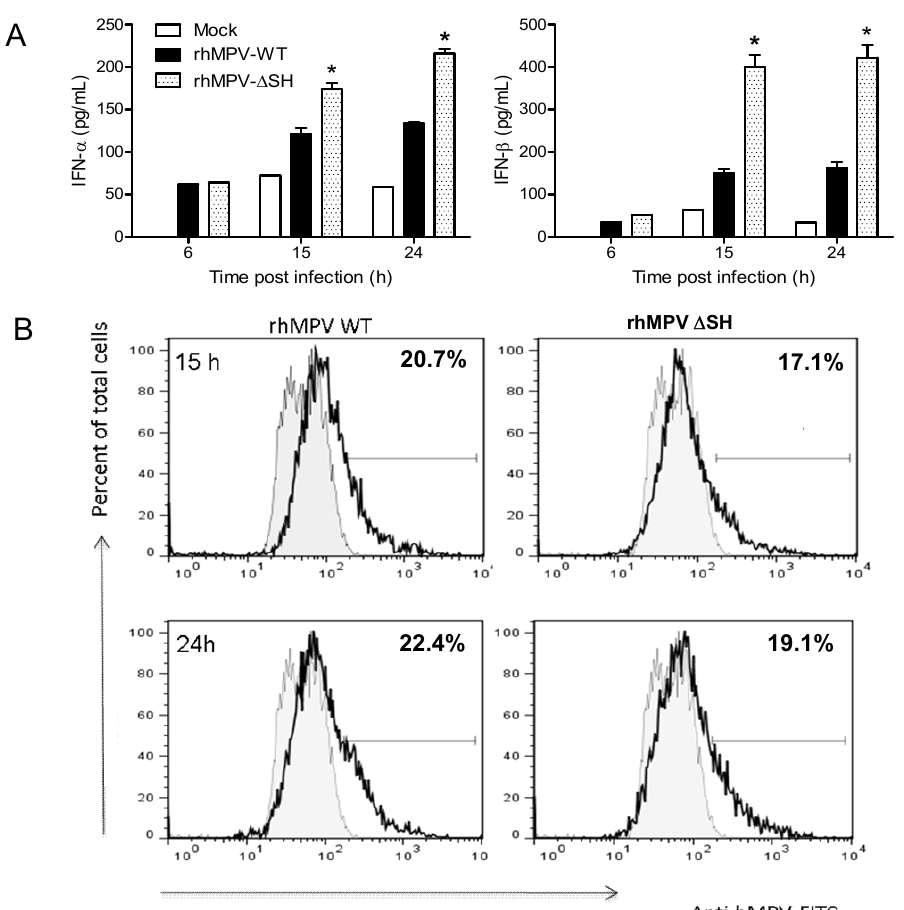
Figure 1. hMPV SH glycoprotein inhibits type I interferon production by human pDCs. ( A ) Isolated human pDCs (1 × 10 5 in 200 µ L complete medium in 96-well plate) were infected with rhMPV-WT or − ∆ SH at MOI of 3. At various time points p.i., cell free supernatants were harvested to measure IFN- α and - β secretion by ELISA. ( B ) Intracellular detection of viral antigens. Virus infected cells were first fixed, permeabilized, and incubated with guinea pig anti-hMPV antibody followed by a FITC-goat anti-guinea pig antibody (Zymed). Cells were analyzed with a FACScan flow cytometer equipped with CellQuest software 8 (San Jose, CA, USA). Analysis was performed in FlowJo software 10 (Treestar, CA, USA). Data represent the mean ± SEM of five independent experiments ( n = 5 donors). * p < 0.05 relative to rhMPV-WT.